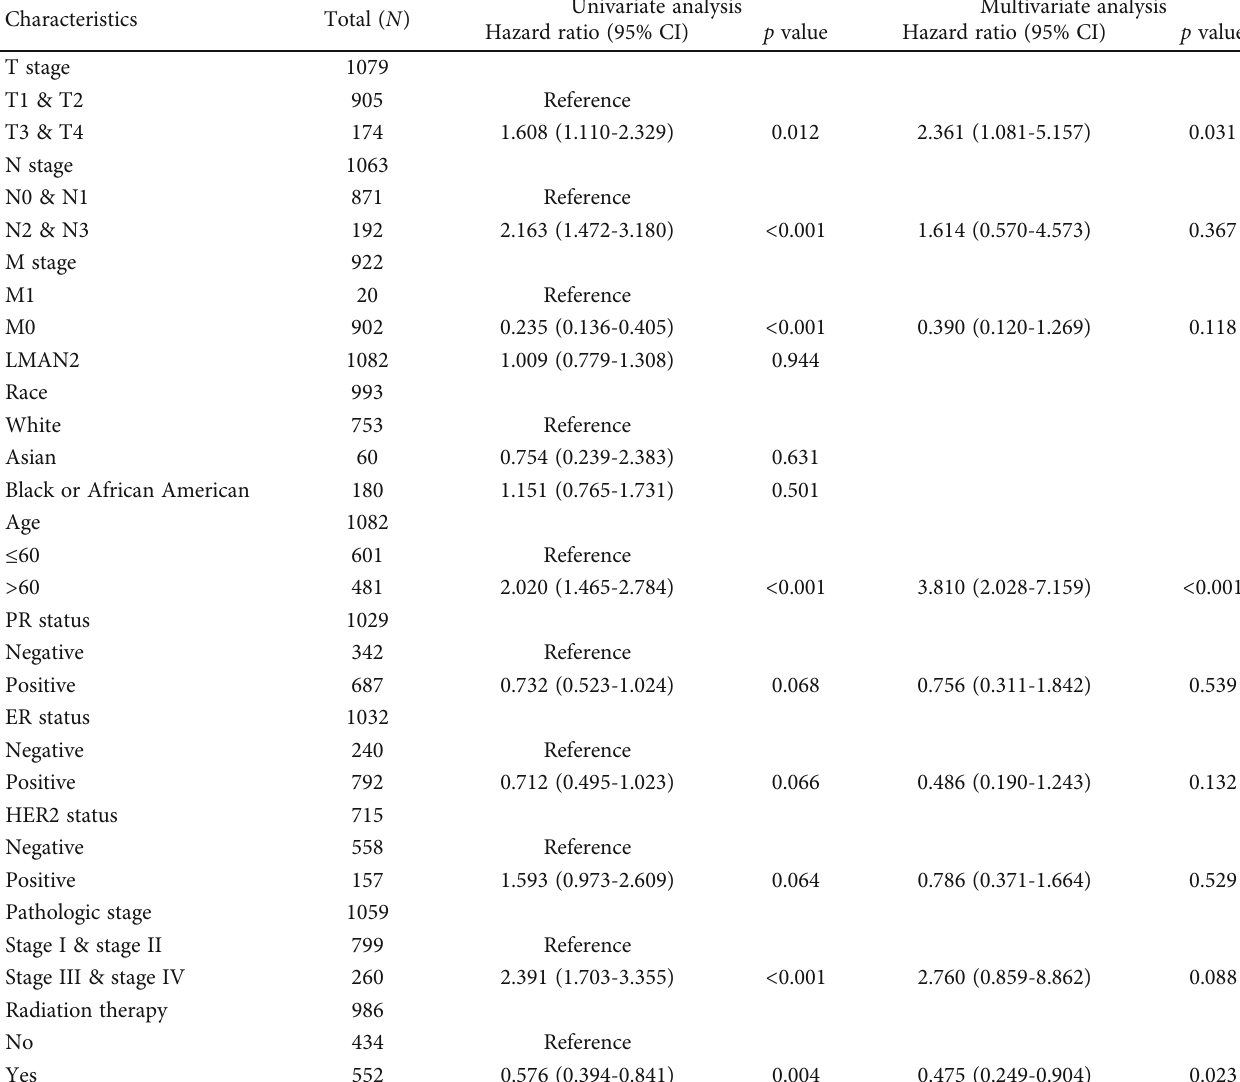
Table 1: Univariate and multivariate analyses of factors associated with LMAN2